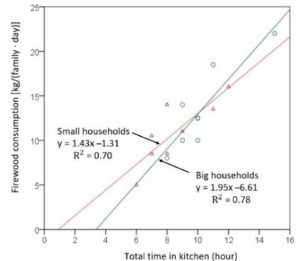
Figure 8. Relationship between firewood consumption and cooking